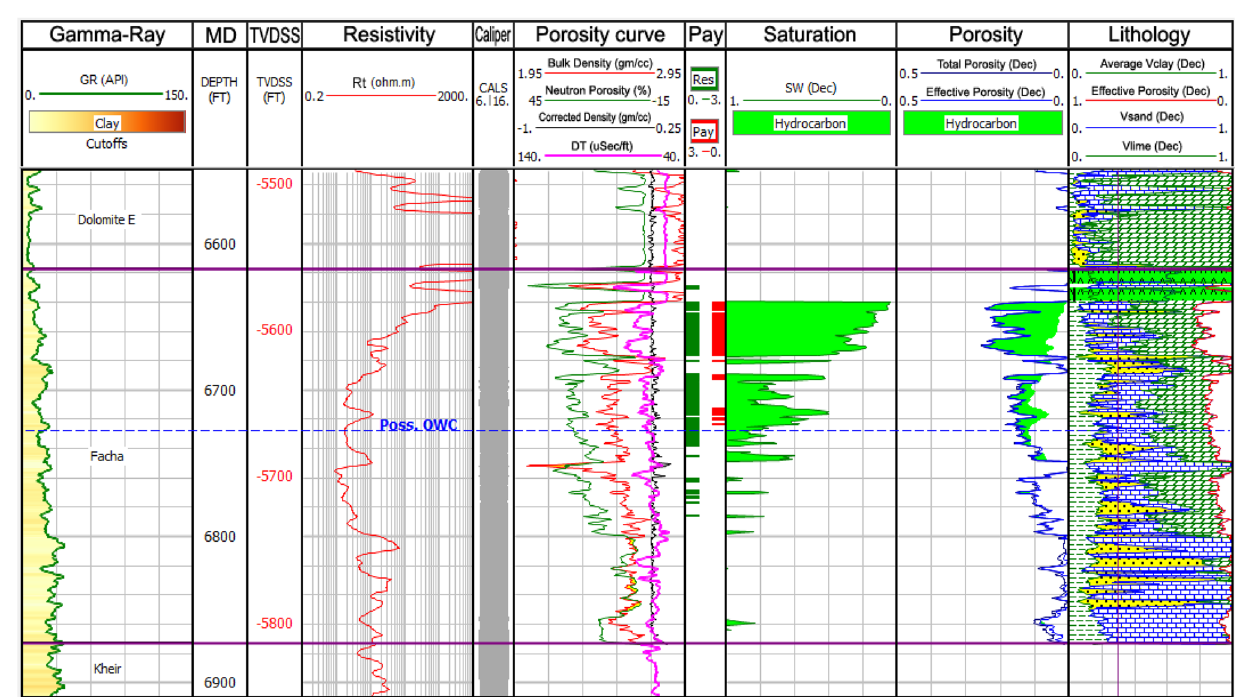
Fig. 9 Litho-saturation log plot of A1 well (as example), Facha